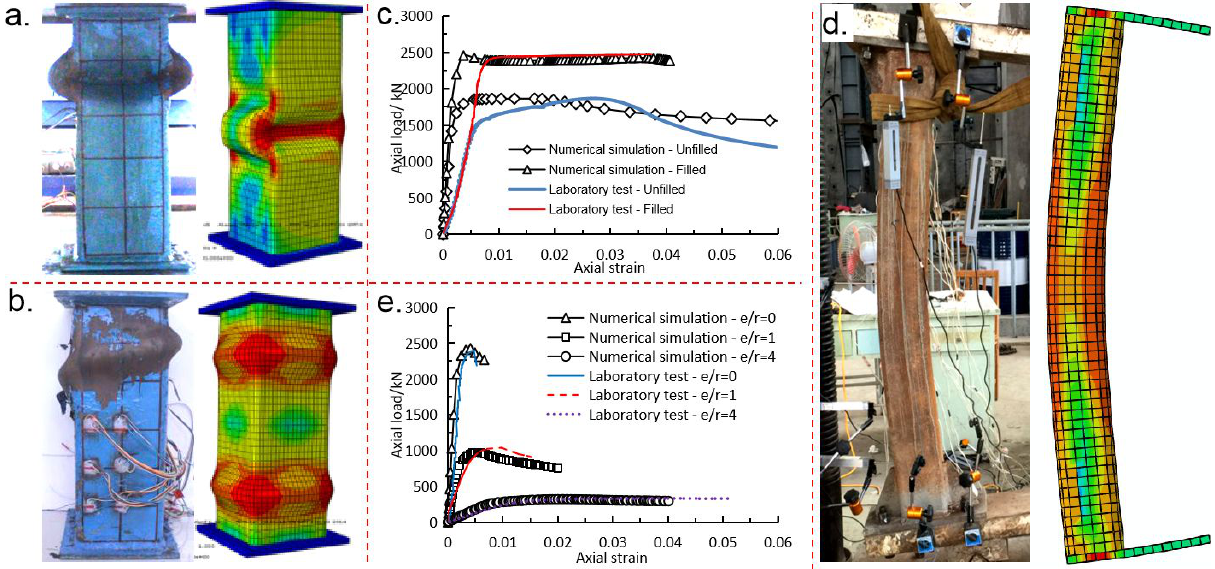
Figure 4: Mechanical tests on the basic CFST structures performed via laboratory tests and numerical